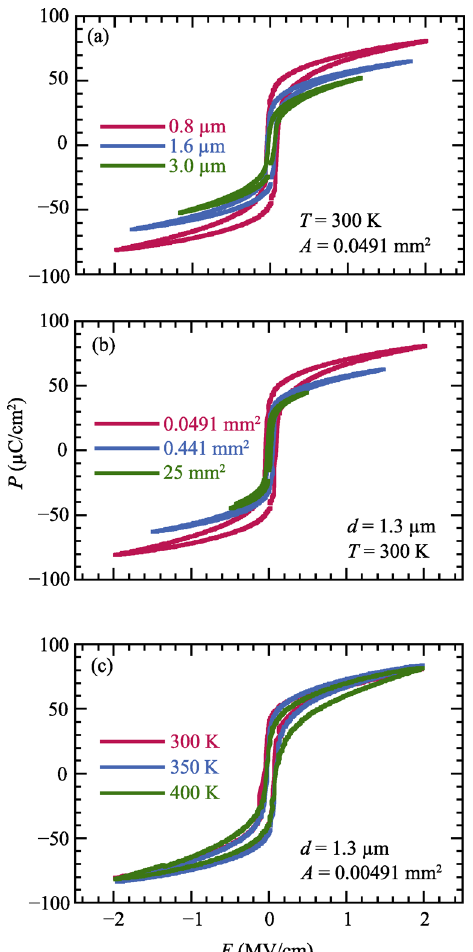
Fig. 4 Polarization hysteresis loops ( E max = E A ) of PLZT films as a function of film thickness (a), electrode area (b), and measurement temperature